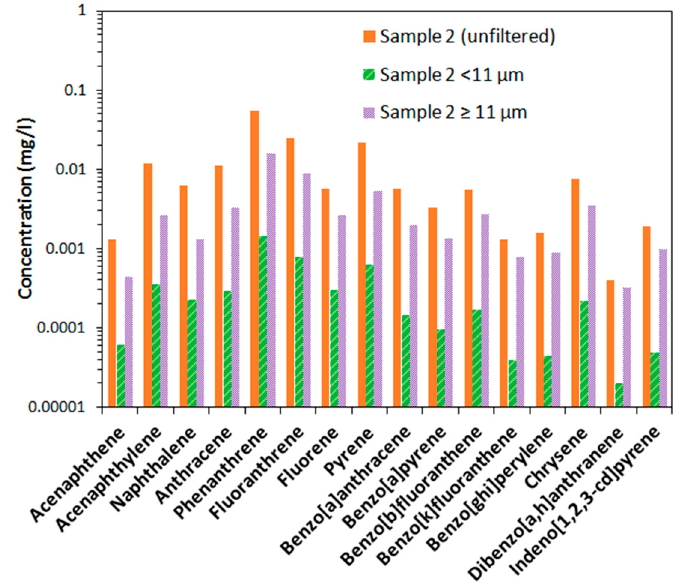
Figure 3. Concentration of PAHs in filtered and unfiltered samples at location 2.